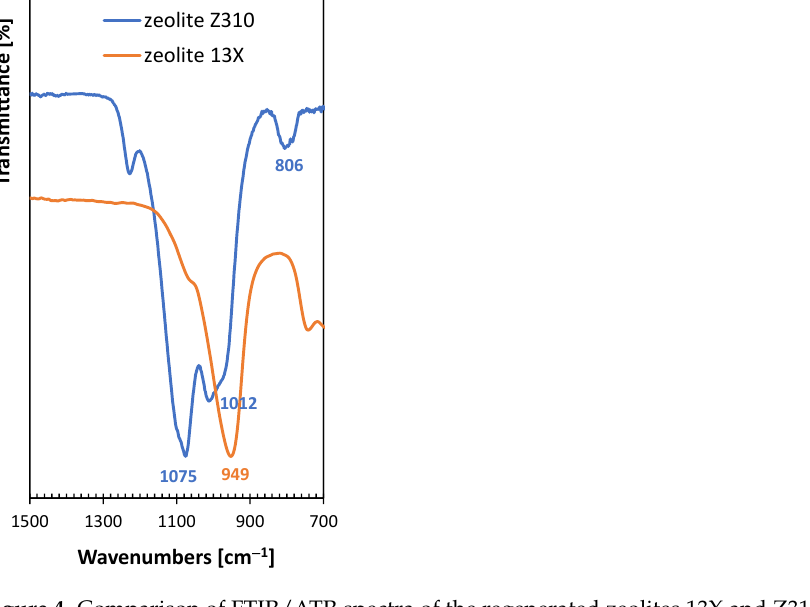
( b ) Figure 5. Panel tests’ results on: ( a ) PW and ( b ) Fil-S samples subjected to different degassing con- ditions. The graphs show that the volunteers judged the odor emitted from the degassed sam- ples slightly less intensely than the untreated ones, even if the AOI values are relatively close to each other. Moreover, degasification resulted as less effective on the deodorization of Fil-S compared to PW. Specifically, PW/HRT evidenced the lowest AOI value, with a reduction of 25% compared to the untreated PW, while in the case of Fil-S, the humid specimen Fil-S_H/HRT showed the greatest reduction in odor intensity with respect to the untreated Fil-S. The higher moisture content of Fil-S_H compared to PW_H (Table 1) sug- gests the need to reach a threshold value in the water amount in order to be effective as a stripping agent. All the samples were also analyzed with the sensor. As specified in detail in the Ex- perimental section (Section 2.3), this sensor allows us to obtain an Index for Air Quality (IAQ), which is correlated with the total level of VOCs (both the odor-active substances and the odorless ones) present in the environment where the material is confined. The results of the analysis with the sensor are reported in Figure 6a,b for PW- and Fil-S-based specimens, respectively.